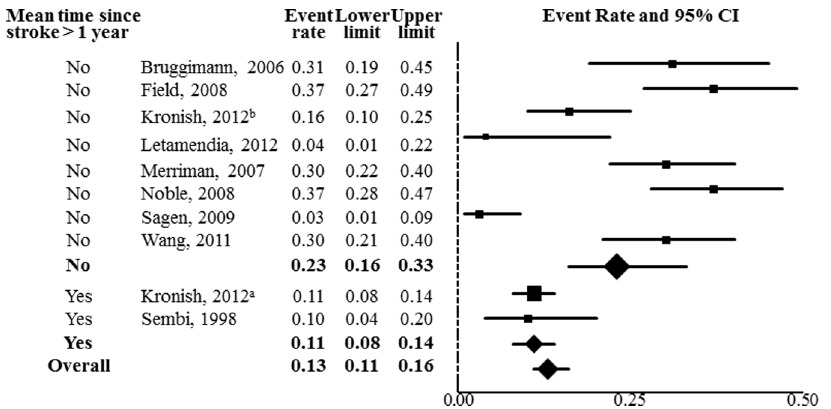
Figure 2. Stroke-induced PTSD prevalence estimates. Note: The area of each square is proportional to the study’s weight in the meta-analysis, and each line represents the confidence interval around the estimate. Diamonds represent aggregate estimates, by PTSD assessment timing and overall, and their lateral points indicate confidence intervals for the estimates.